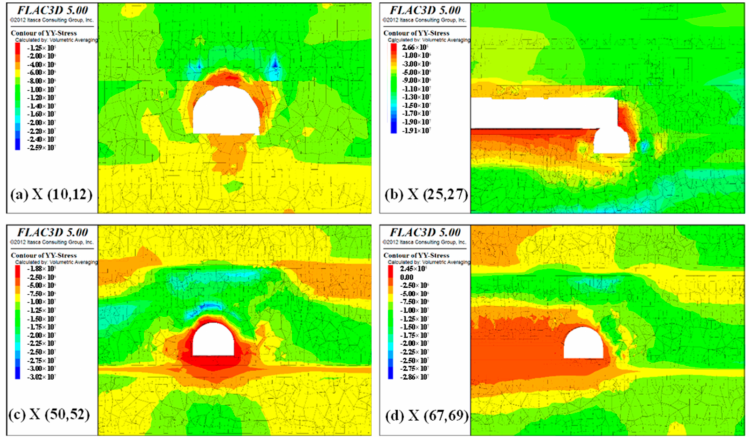
Figure 18. Y − direction stress distribution of the four monitoring areas after excavation of head chamber in belt